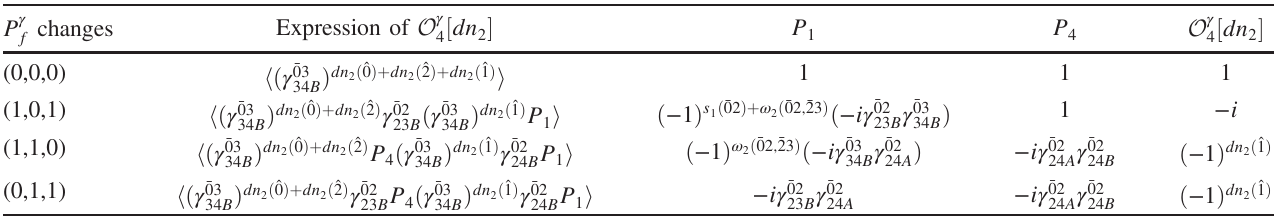
TABLE IV. Calculations of O γ 4 ½ dn 2 (cid:2) for all possible Kitaev chain configurations in the superpentagon equation in Fig. 3. The first column is the Majorana fermion parity change triple ½ dn 2 ð different cases. The second column is a simplified version of Eq. (140) for each case. The third and fourth columns are the Majorana pairing projection operators we use in calculation. The last column is the final result of O γ 4 ½ dn 2 (cid:2) , which can be summarized by Eq.